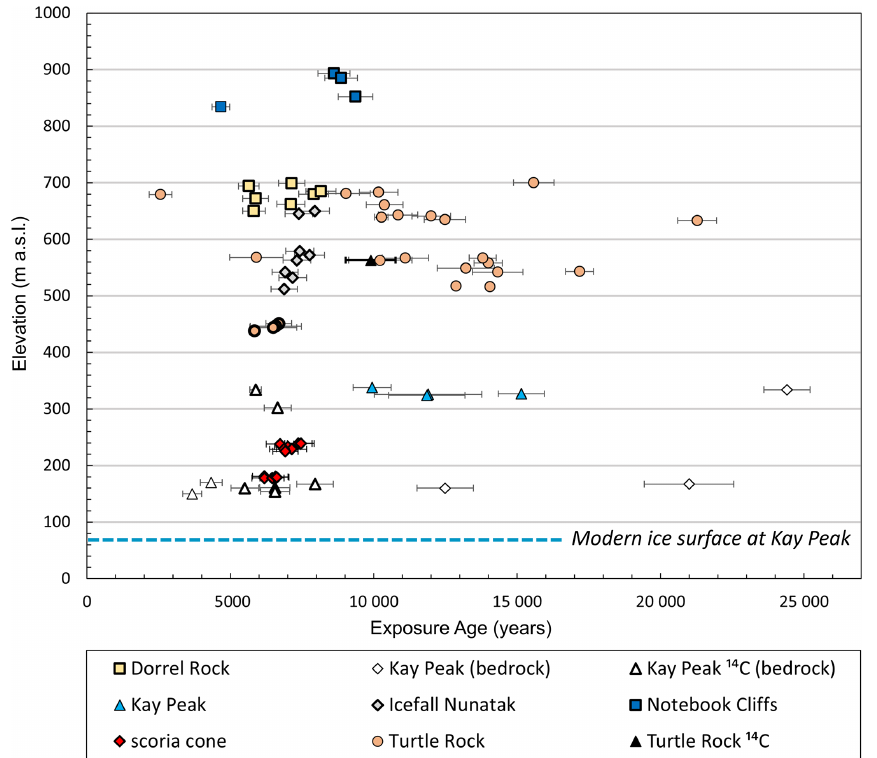
Figure 7. New exposure ages obtained from the scoria cone in comparison with exposure age data reported by Johnson et al. (2008, 2020) for nunataks surrounding Mt. Murphy. Exposure ages are plotted as 10 Be and in situ 14 C exposure ages (years) versus elevation (ma.s.l.). Filled symbols represent erratics and open symbols represent bedrock samples; all symbols represent 10 Be exposure ages unless specified as in situ 14 C in the key. Error bars represent external uncertainty in years (1 σ) . Bold outline indicates samples used for sample set 4 linear regression analysis. Dashed blue lines show the modern ice surface elevation near Kay Peak ridge (which is < 1km from the present grounding line; Fig. 1c). Note symbols for previous and new exposure ages are the same as in Fig. 1b and